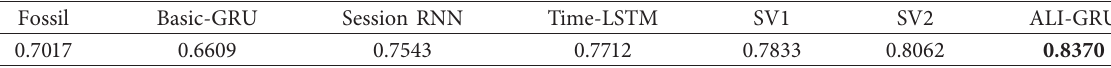
Table 3: Comparison results on offline dataset.